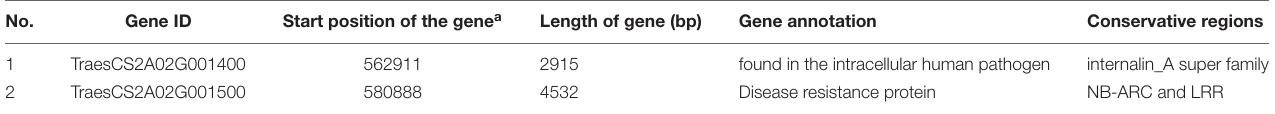
TABLE 3 | Candidate genes in the most distal 60.11kb region of 2AS.